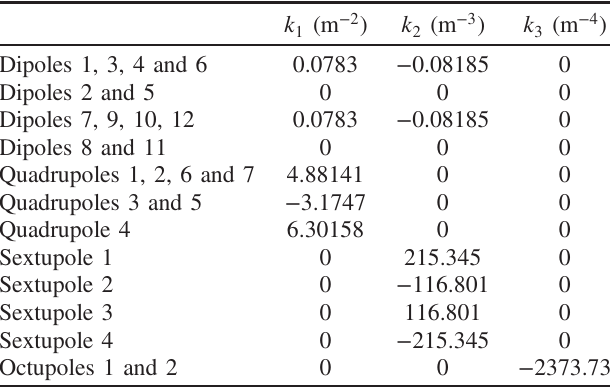
TABLE I. Magnet parameters for MAX IV BC1 with additional dipoles. We choose as an example the first-order isochronous, second-order linearized solution: R 56 ¼ 0 cm, T 566 ¼ − 4 . 0